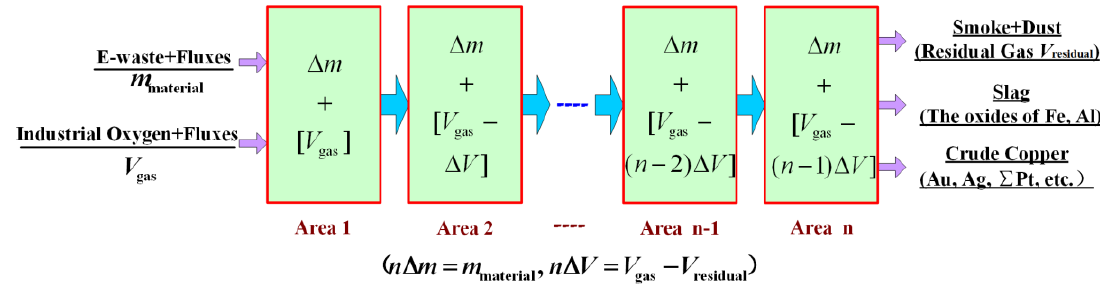
Figure 2. The description of the local equilibrium physical model for top-blowing smelting of electronic waste.